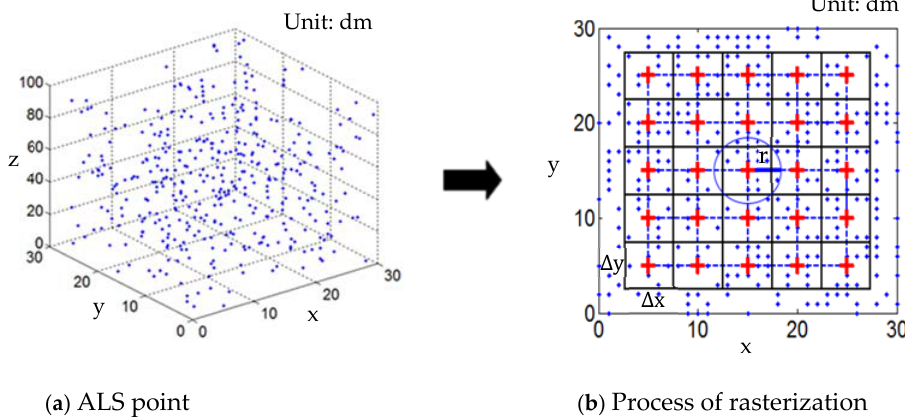
Figure 4. The process of rasterizing ALS point cloud data to the digital surface model (DSM). The blue point represent the ALS point. The black rectangles represent the rasterized pixels and the red cross represents the value of a rasterized pixel.